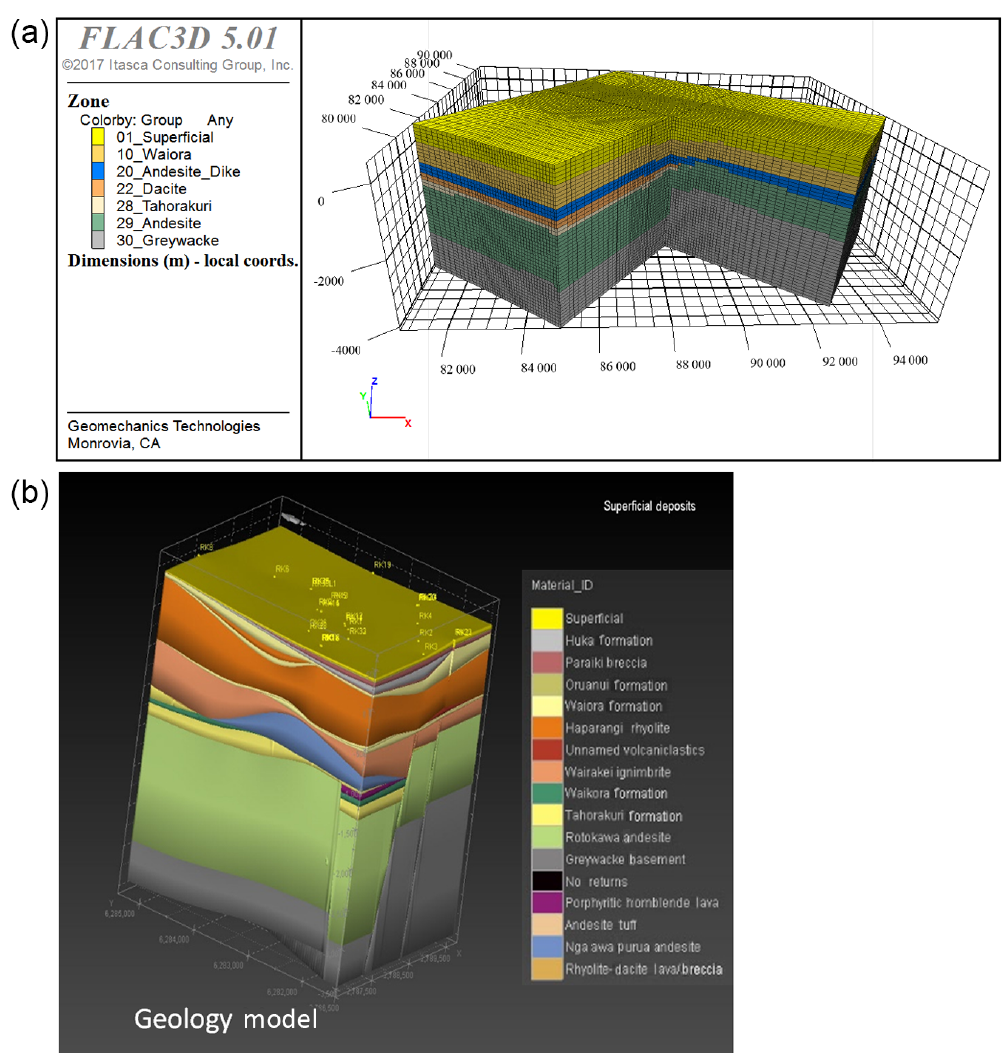
Figure 4. Integrated geological (a) and geomechanical model (b) – some geological layers were combined, due to coarser resolution of the geomechanical model compared to the geological